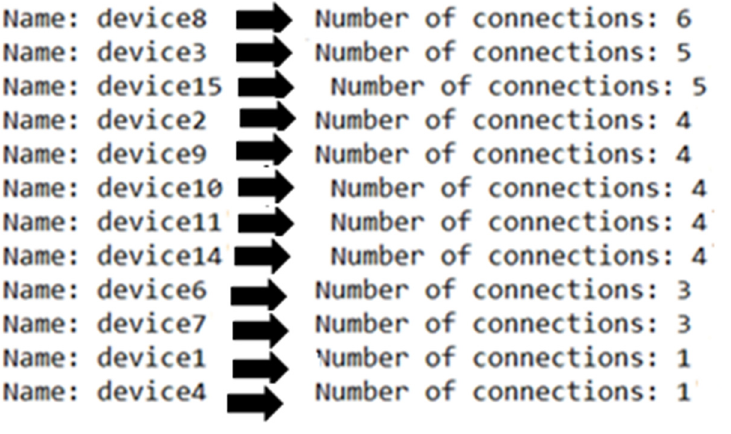
Figure 4. Ranking critical assets result.